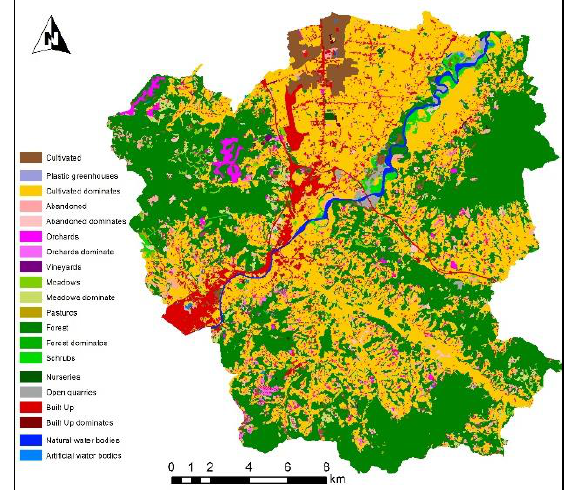
Figure 2. The spatial distribution of classes in LC/LU